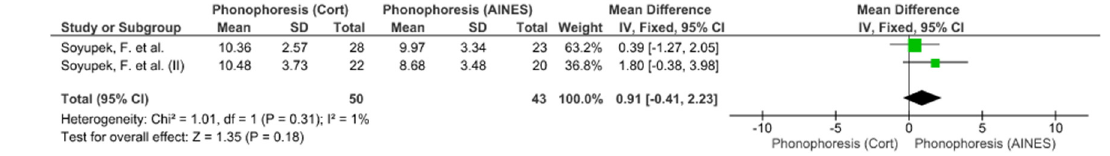
Figure 12. Phonophoresis for CMAPam.